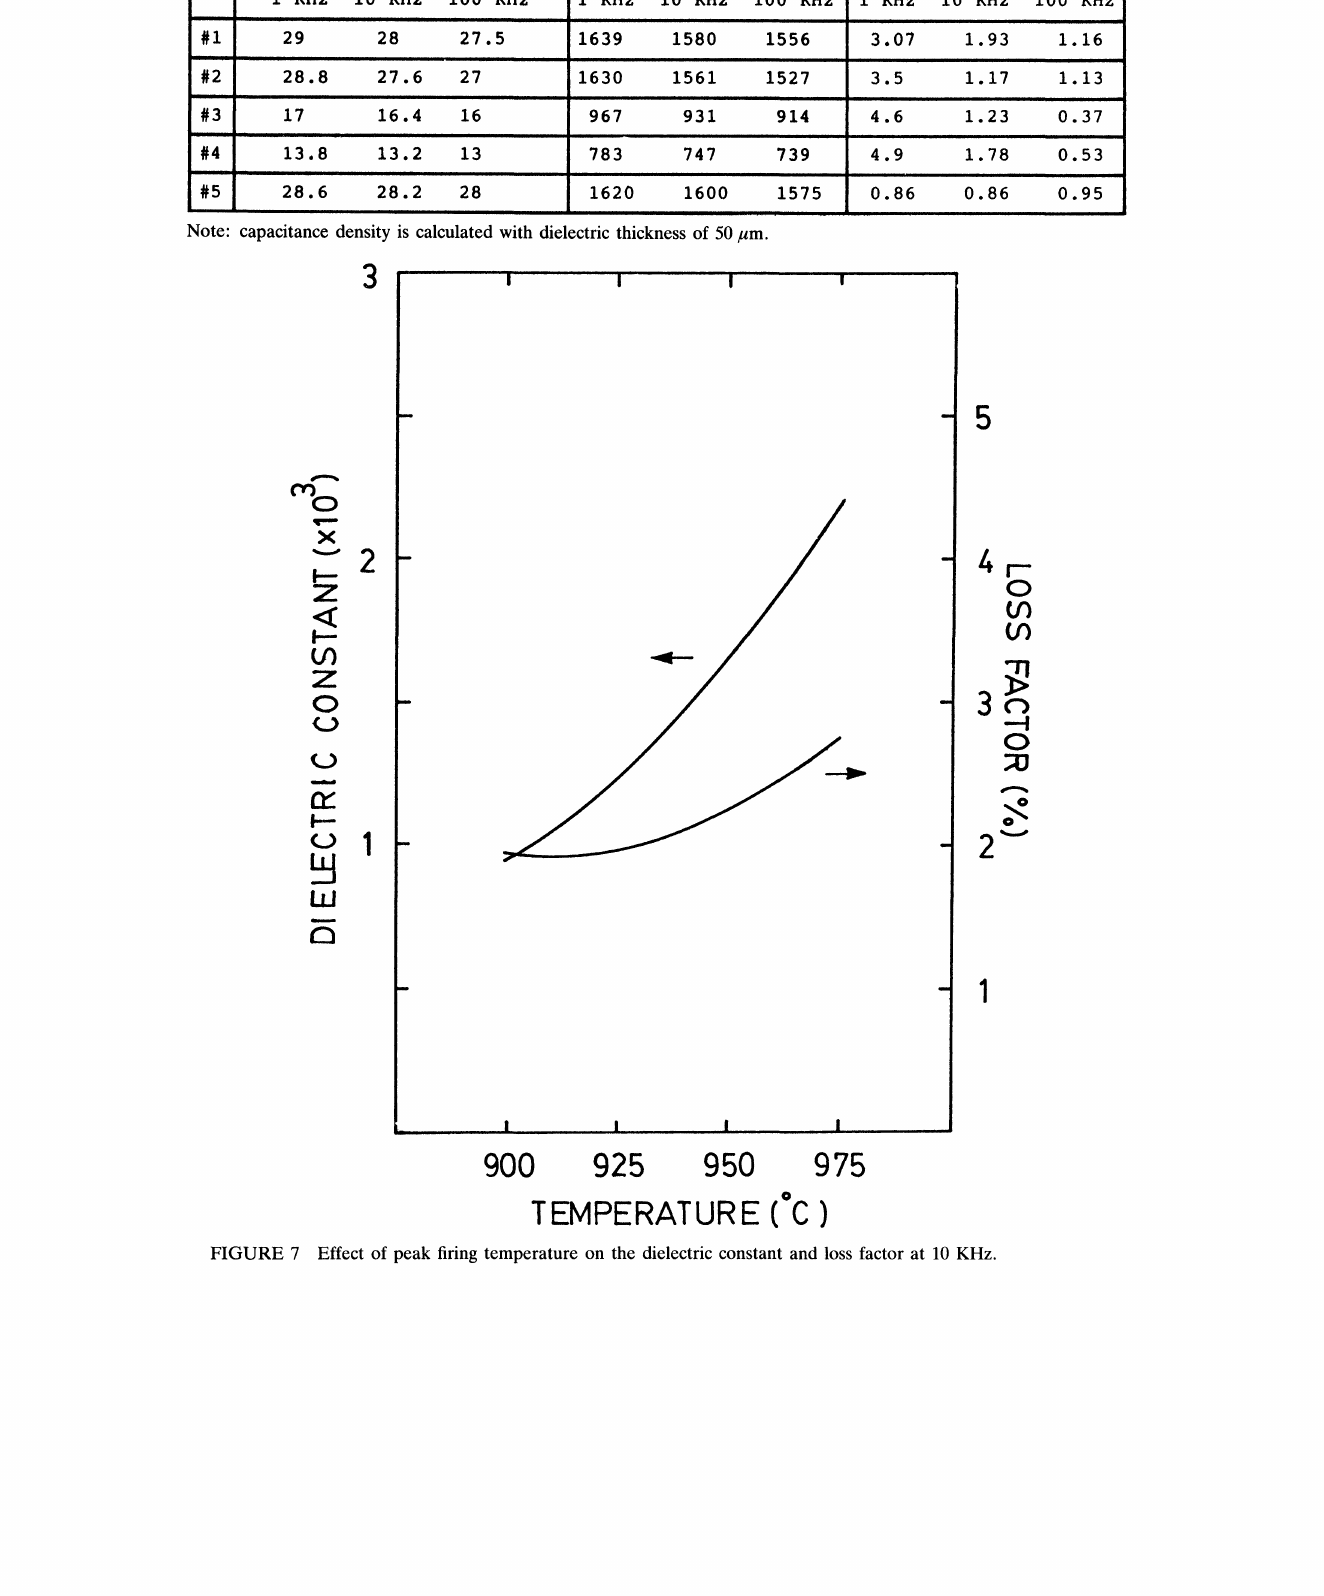
TABLE II Typical dielectric properties of #1, #2, #3, #4 and #5 at room temperature.